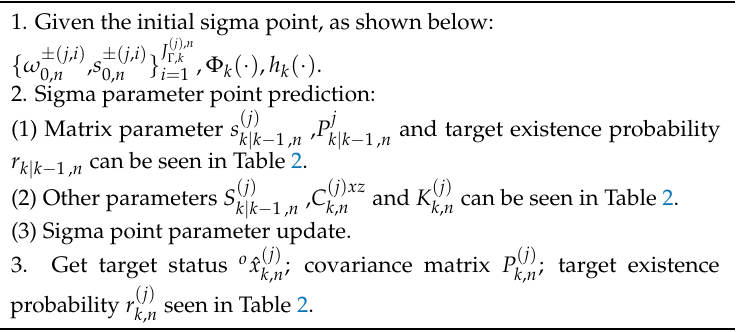
Table 1. The UKF GLMB Algorithm [19].